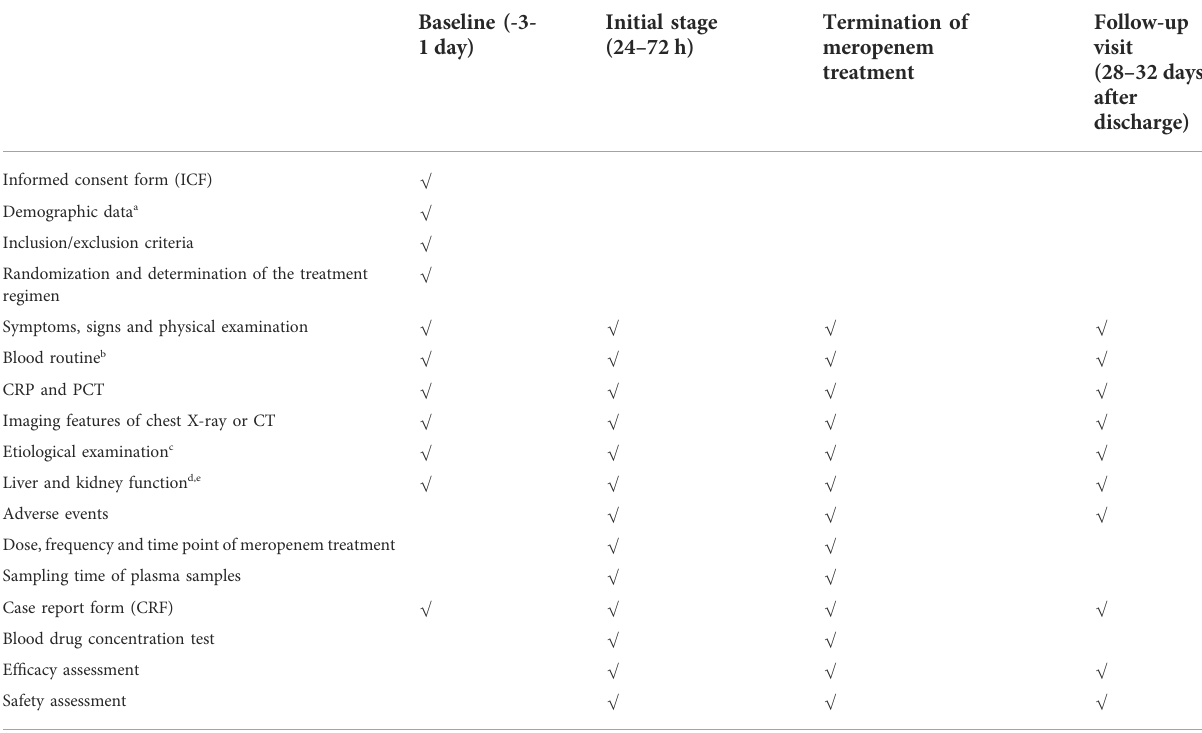
TABLE 2 Schedule of enrollment, interventions, and